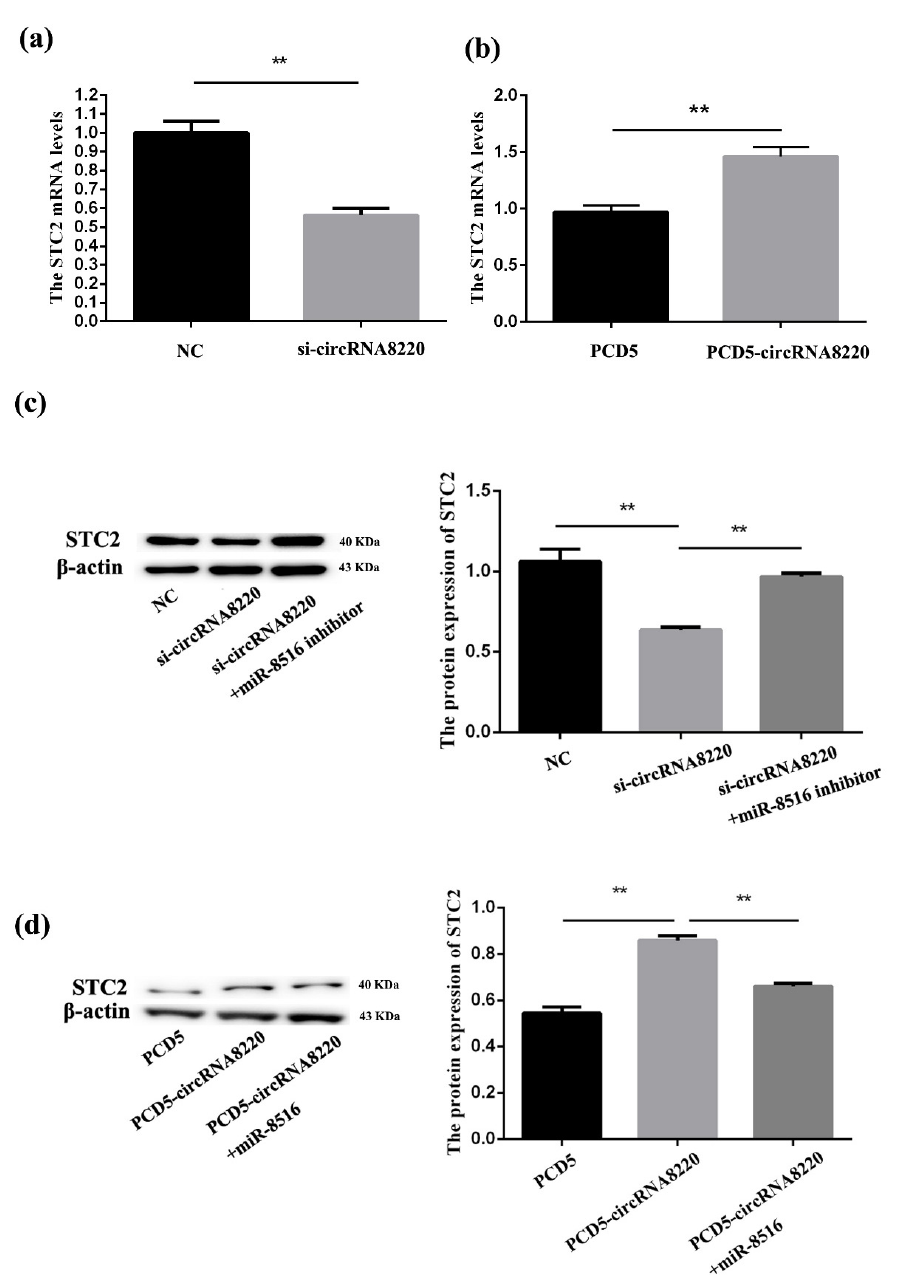
Figure 3. circRNA8220 increased the expression of STC2 in GMEC in vitro. ( a ) si-circRNA8220 reduced the mRNA expression of STC2. ( b ) circRNA8220 increased the mRNA expression of STC2. ( c ) si-circRNA8220 blocked the protein expression of STC2. ( d ) circRNA8220 raised the protein expression of STC2. ** p <